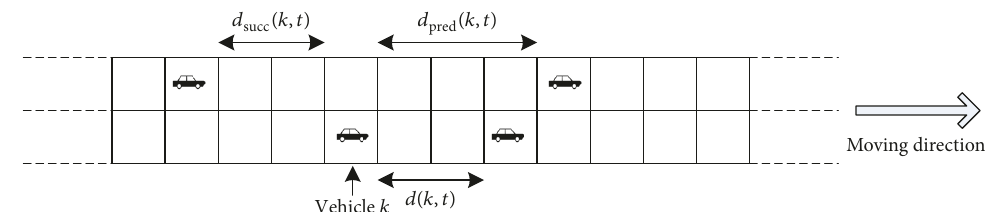
Figure 1: Corresponding positions of vehicles for lane changing rules in the STCA